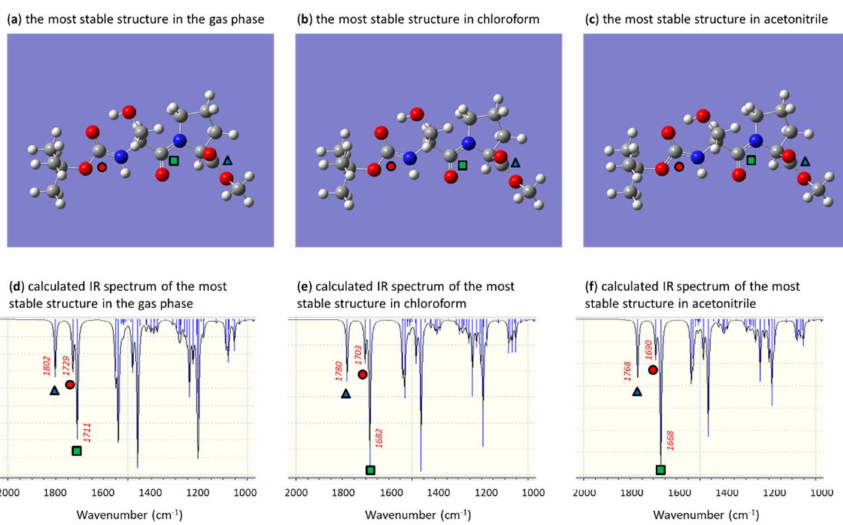
Figure 21. The most stable structure and calculated IR spectra of N -Boc-L-serine-L-proline-OMe 10 : ( a ) the most stable structure in the gas phase, ( b ) the most stable structure in chloroform, ( c ) the most stable structure in acetonitrile, ( d ) calculated IR spectrum in the gas phase, ( e ) calculated IR spectrum in chloroform, ( f ) calculated IR spectrum in